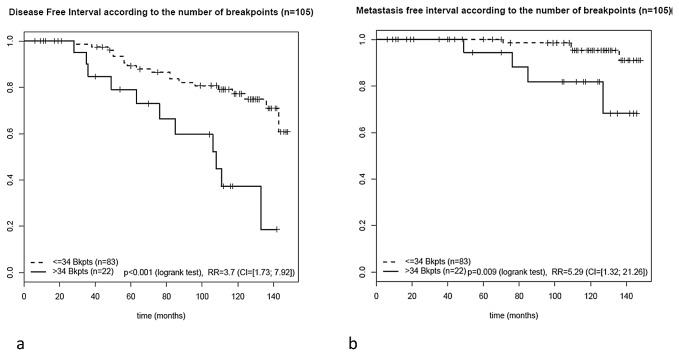
Disease free-interval (a) and metastasis free-interval (b) analyses (Kaplan Meier analysis and log rank test) in the validation set.